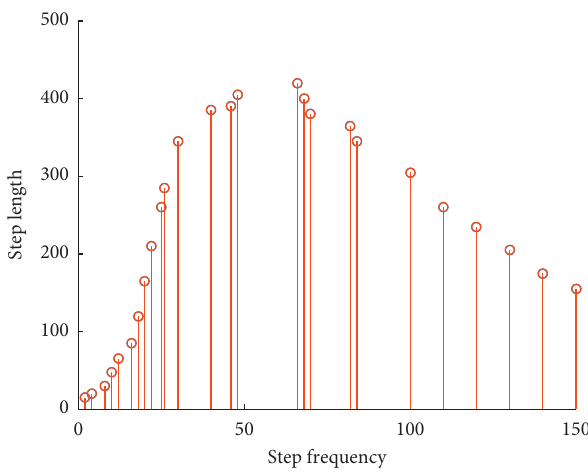
Figure 6: Human walking step length and step frequency simulation.